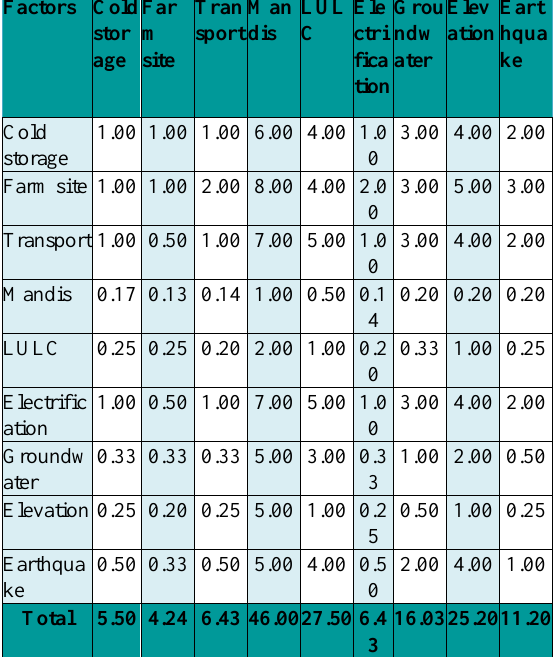
Table 3. Matrix for pair-wise comparison of criteria